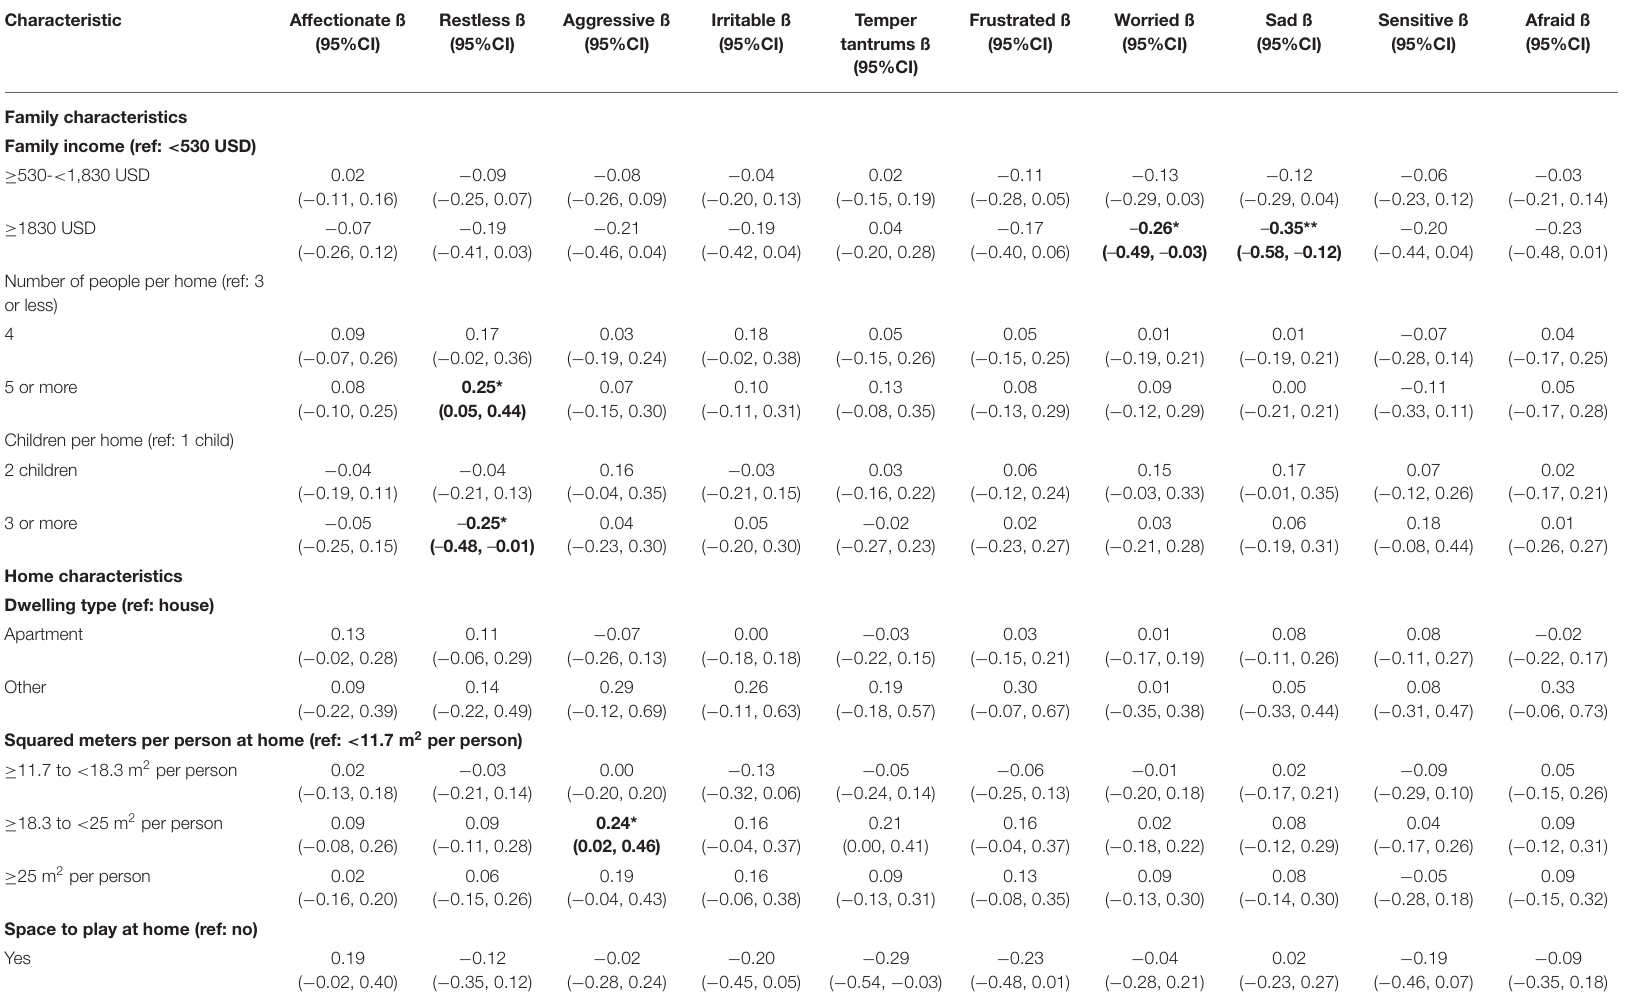
TABLE 3 | Family, home and geopolitical characteristics associated with emotional changes in toddlers and preschoolers during early stages of the COVID-19 pandemic ( n = 1,727).